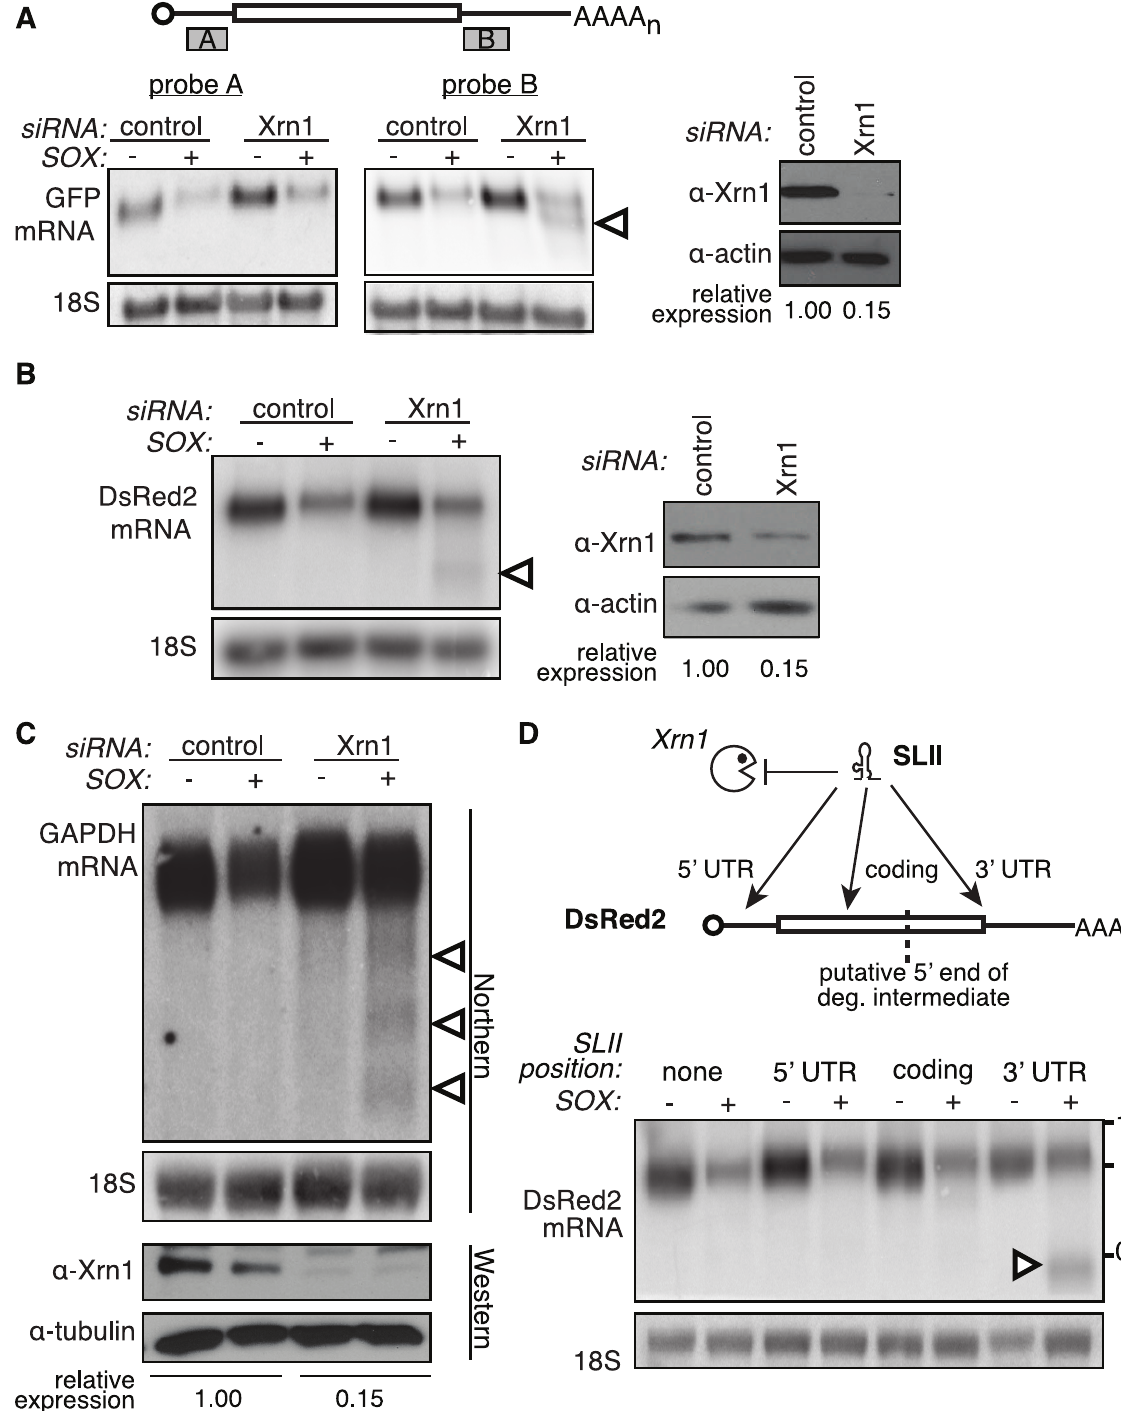
Figure 1. Xrn1 is required for the removal of a 3 9 intermediate during SOX-mediated mRNA degradation. (A–B) 293T cells were treated with control or Xrn1 siRNAs, then transfected with the indicated reporters + / 2 SOX. The level of Xrn1 protein depletion is shown on the right, with actin as a loading control. (A) Diagram depicts location of probes on the GFP message. Northern blots using probes against either the 5 9 (probe A; left panel ) or 3 9 (probe B; right panel ) UTR of the GFP mRNA reporter or 18S. (B) Northern blots using probes against the 3 9 UTR of the DsRed2 mRNA reporter, or 18S ( left panels ). (C) 293T cells were treated with control or Xrn1 shRNAs, then transfected with GFP ( 2 ) or GFP-SOX ( + ). Cells were then selected for GFP fluorescence by FACS before RNA and protein collection. RNA was Northern blotted with probes to the 3 9 end of the GAPDH coding region, or to 18S. The level of Xrn1 knockdown was assessed by Western blot, using tubulin as a loading control. In panels A, B and C, arrowheads denote degradation intermediates. (D) A flaviviral Xrn1-blocking element (SLII) was inserted at different positions within the DsRed2 mRNA. RNA from 293T cells transfected with the indicated reporter + / 2 SOX was Northern blotted using a probe directed against the 3 9 UTR of the DsRed2 reporter, or 18S. The full-length mRNA is , 1.2 kb, and the expected size of the fragment protected from Xrn1 degradation by SLII within the 5 9 UTR is , 1.1 kb, within the coding region is , 900 bp, and within the 3 9 UTR is , 500 bp. Arrowhead denotes protected fragment.